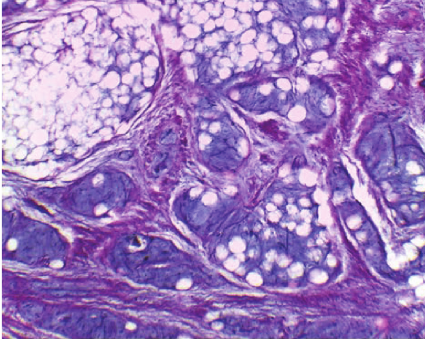
Figure 11: Histopathology of the specimen in Case 3. The tumor showed lobulated appearance consisted of mature adipocytes and myxoid parts (Hematoxylin and Eosin × 100)